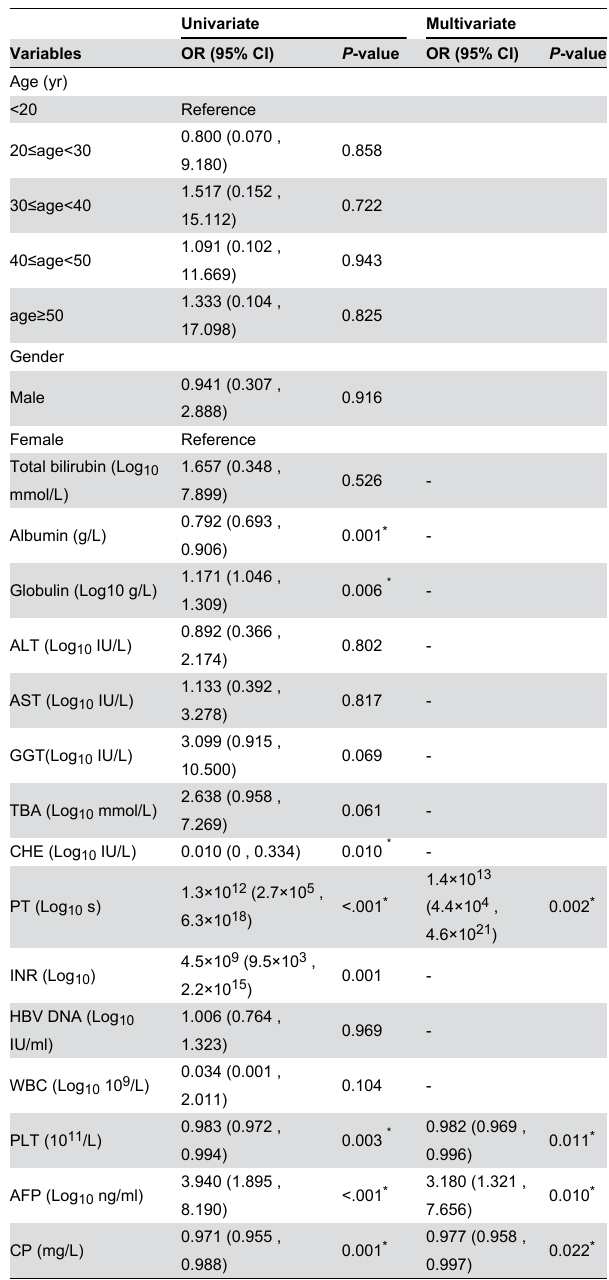
Table 5. Univariate and multivariate logistic regression analysis to determine factors significantly associated with cirrhosis in training group